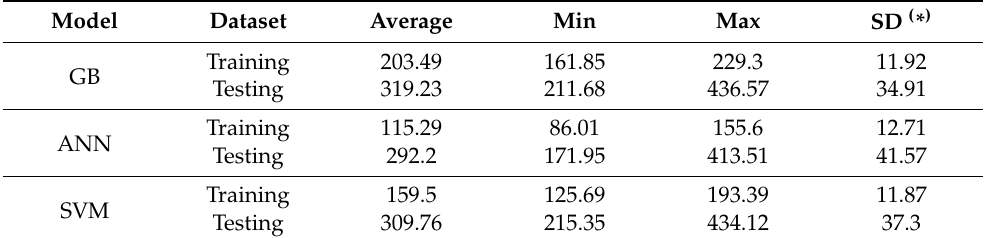
Table 6. Summary of the 300 samplings using MAE